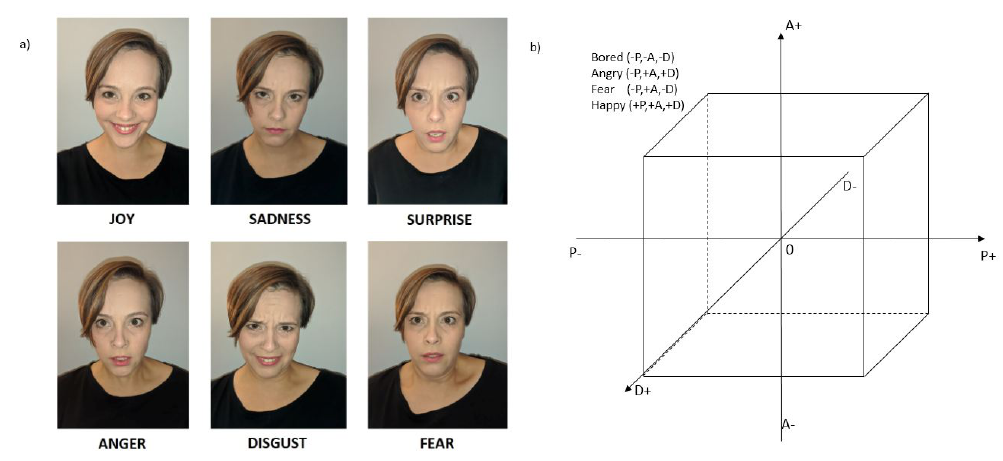
Figure 2. ( a ) Sample illustrations of six Ekman’s emotions ( b ) Sample representation of PAD